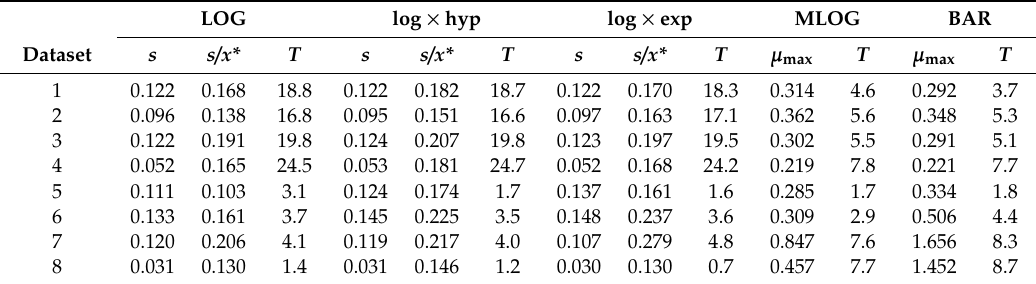
Table 2. Comparison of maximum growth rate ( s , units of microbial mass per h), scaled maximum growth rate ( s / x *, h − 1 ), lag time ( T , h ) and maximum relative growth rate ( µ max , h − 1 ), generated by the standard logistic (LOG), logistic × hyperbola (log × hyp) and logistic × exponential (log × exp) fitted to optical density (OD) growth data and the modified logistic (MLOG) and four-parameter Baranyi (BAR) fitted to logarithmic transformed growth data [ln(OD / OD 0 )].